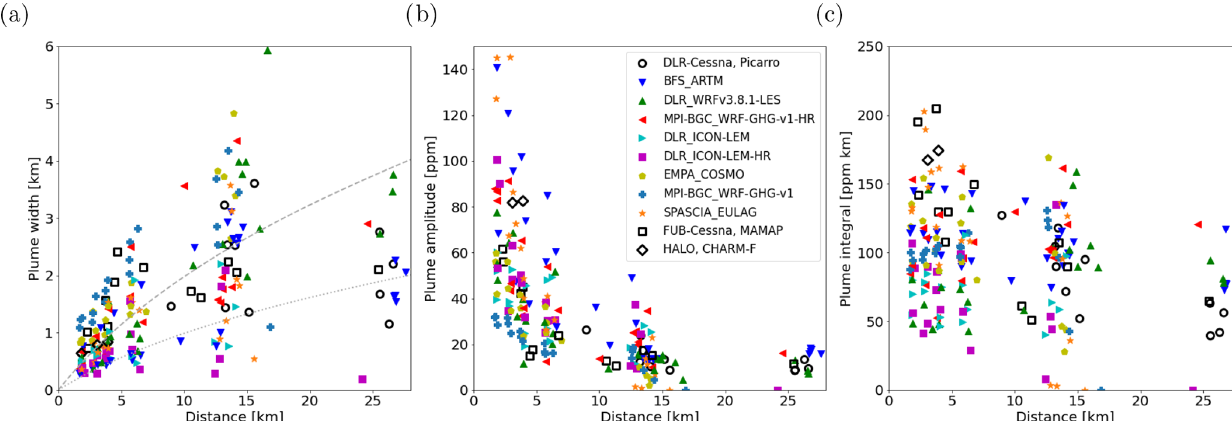
Figure 12. Comparison between observed and simulated characteristics of the CO 2 plume of the Bełchatów power plant on 7 June 2018 as a function of distance from the source. Plume characteristics were determined by fitting a Gaussian distribution to the individual plume transects. (a) Plume widths ( σ · cf). (b) Plume amplitudes (maximum of the Gaussian distribution). (c) Plume areas A . Observations are shown as black open symbols and models as filled colored symbols. Symbols are only shown when the Gaussian fit was sufficiently robust (uncertainty in plume width < 10%) and the plume was not too close to the border of the transect. Gray lines describe plume width of an analytical Gaussian plume model, following Briggs (1973), for highly (dashed) and weakly unstable (dotted)